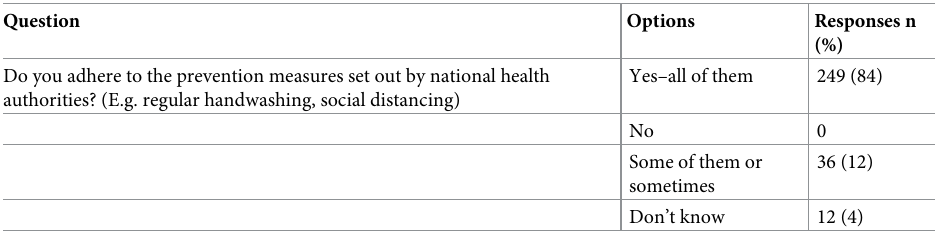
Table 4. General attitudes and practices towards COVID-19 among respondent APEs (N =